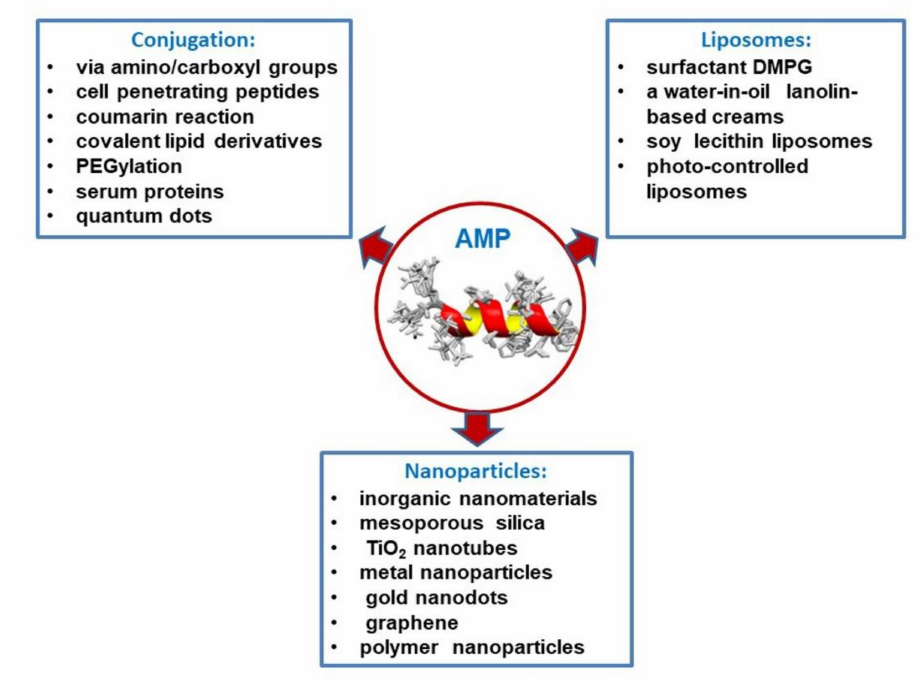
Figure 5. Desired general features for an efficient AMP delivery